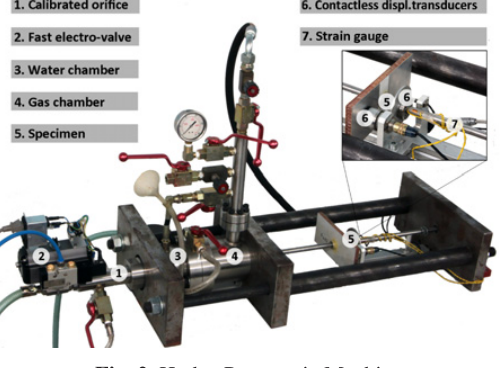
Fig. 2. Hydro-Pneumatic Machine.